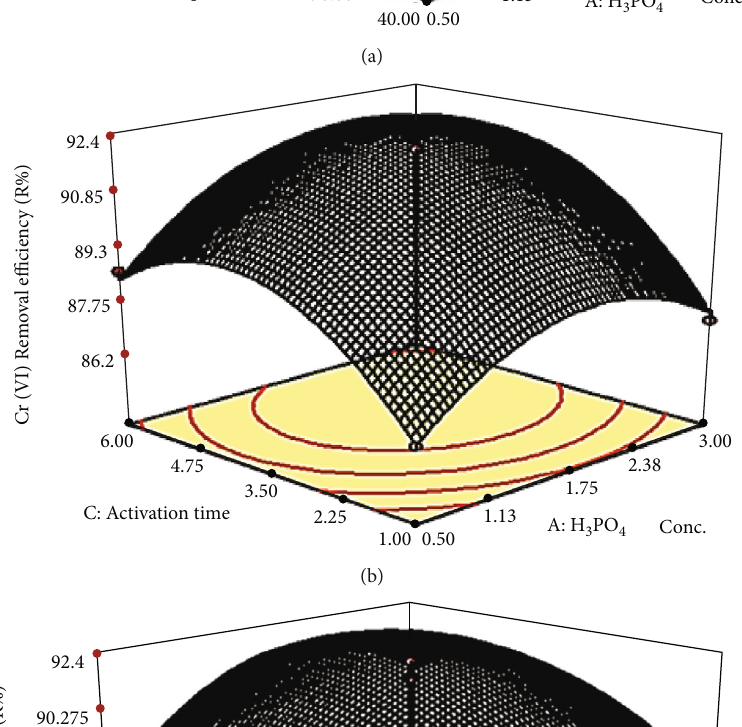
PO concentration vs. activation temperature, 3 4